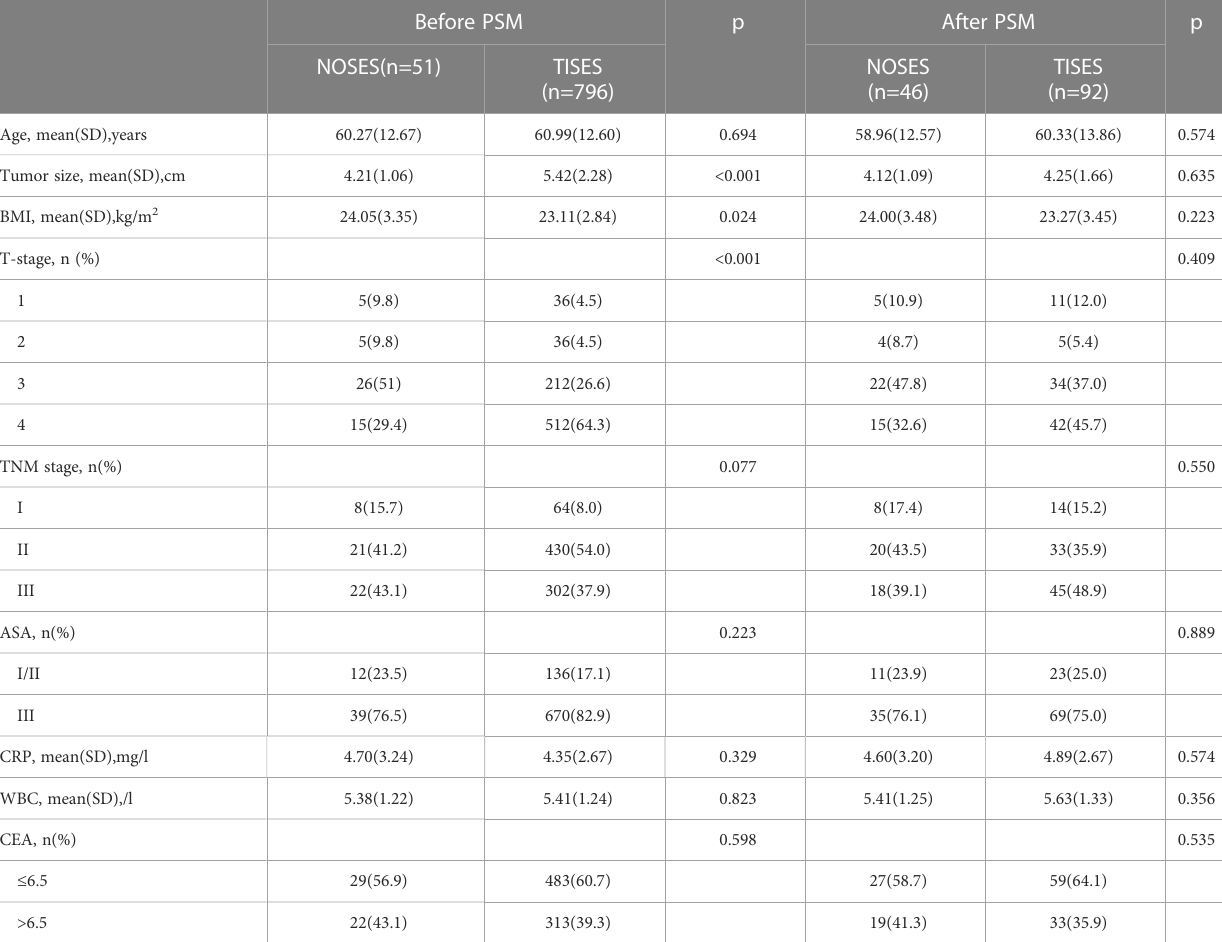
TABLE 1 Comparison of clinicopathological data of patients in two groups.